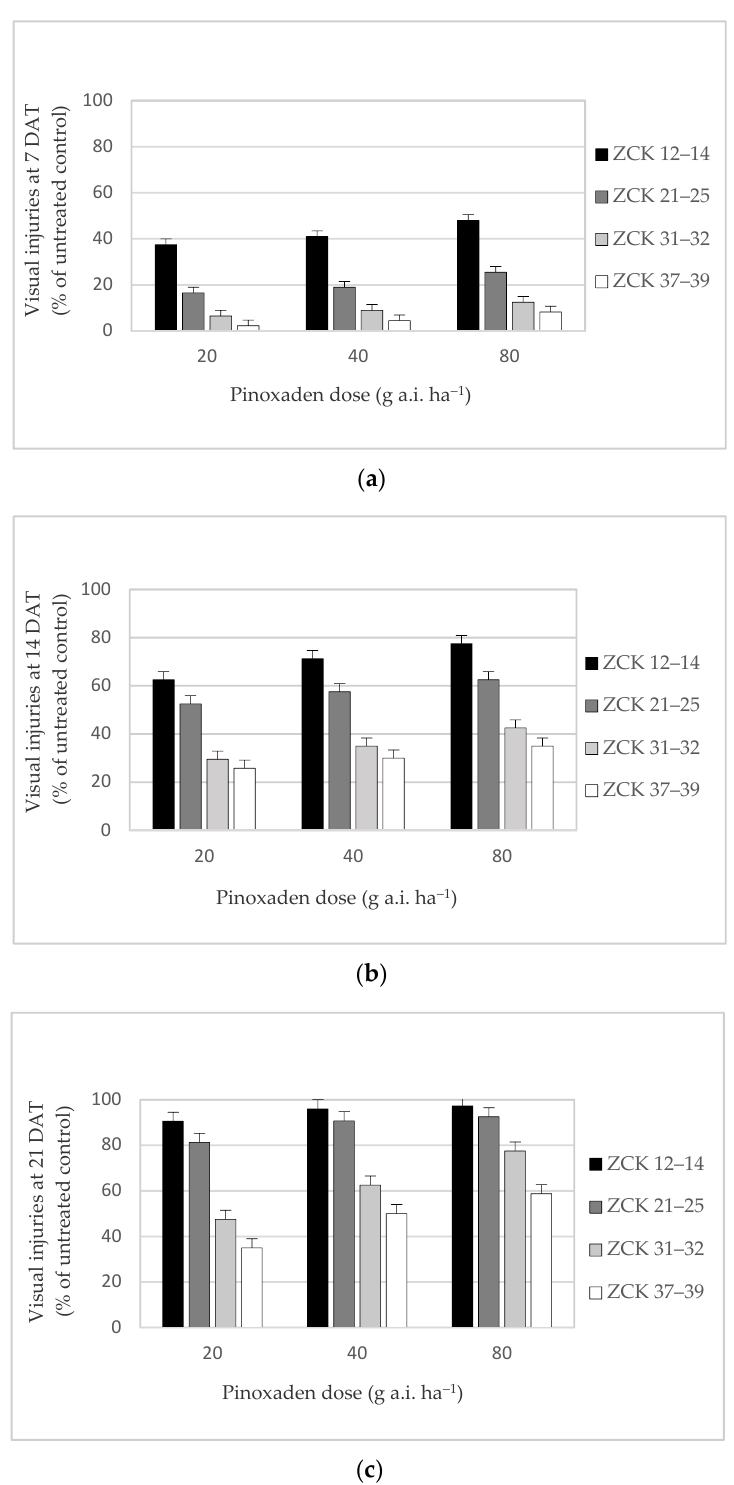
Figure 1. Visual injuries (% of untreated control) of A. myosuroides at 7 ( a ), 14 ( b ) and 21 ( c ) days after treatment (DAT) with various pinoxaden doses at different growth stages. Vertical lines indicate a statistical difference according to Fisher’s Least Significant Difference (LSD) test at p < 0.05. LSD ( a ) = 3.02; LSD ( b ) = 4.45; LSD ( c ) = 5.14. Greenhouse experiment had four replicates with 10 plants in each pot and was conducted over two years with data pooled across years.